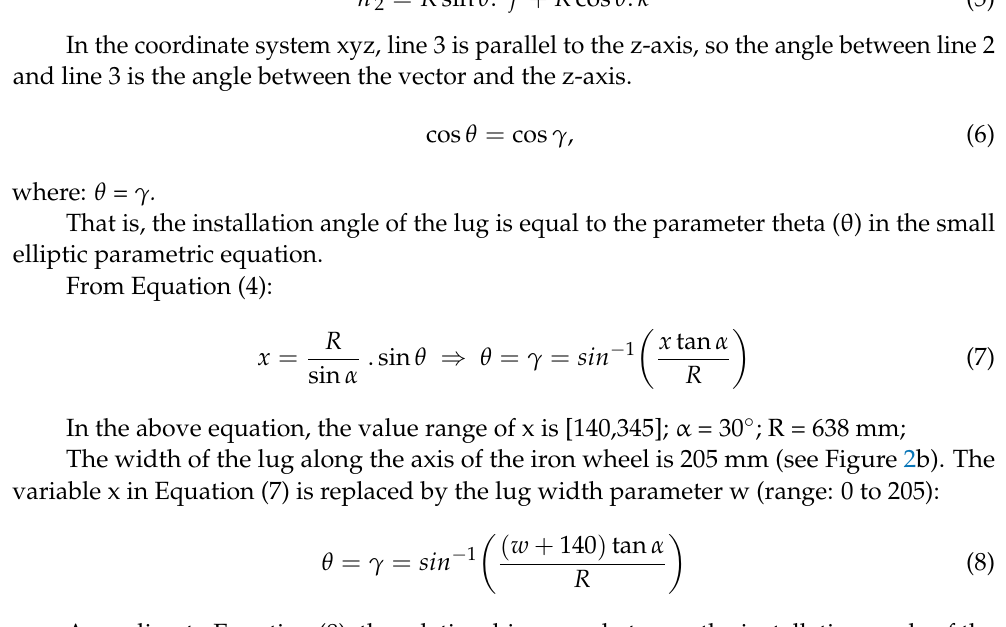
Figure 3. Schematic explanation diagram of working faceplate mounting angle (a) Design model, (b) Prototype “labeling is explained in paragraphs where cited”. From Equation (4):